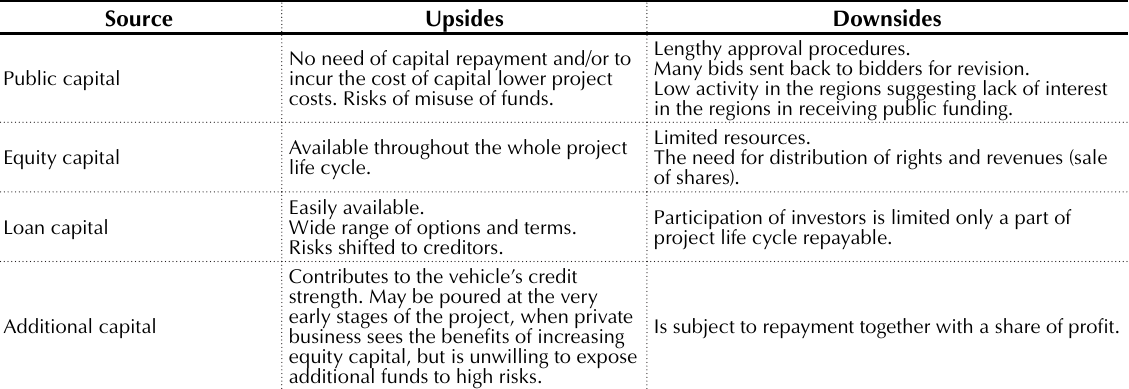
Table 2. An outline of PPP structure according to sources of project vehicle